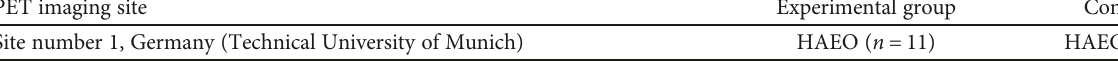
Table 1: Details of di ff erent groups imaged at the various sites (Germany, USA, Denmark, and Belgium; see text for details). PET imaging